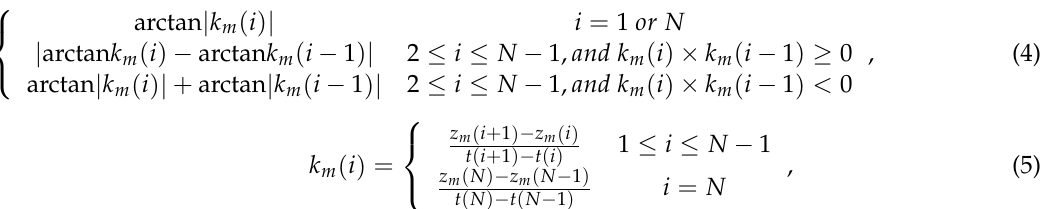
Figure 1. Z m is selected as an example, and for i = 1 or N , θ m ( 0 ) is the rotation angle between the first line segment and a horizontal line, θ m ( N ) is the rotation angle between the last line segment and a horizontal line, and k m ( i ) is the slope of the i th line segment, which is defined by Equation (5).